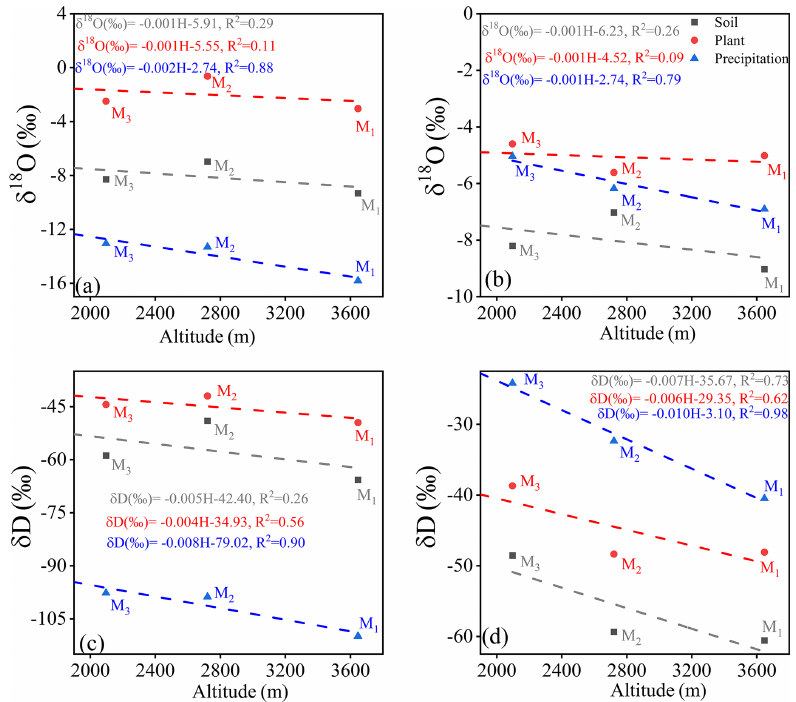
Figure 7. Relationship between different isotopes and altitudes in the dry season (a,c) and in the rainy season (b,d) ; M 1 stands for alpine meadows; M 2 stands for forests; and M 3 stands for arid